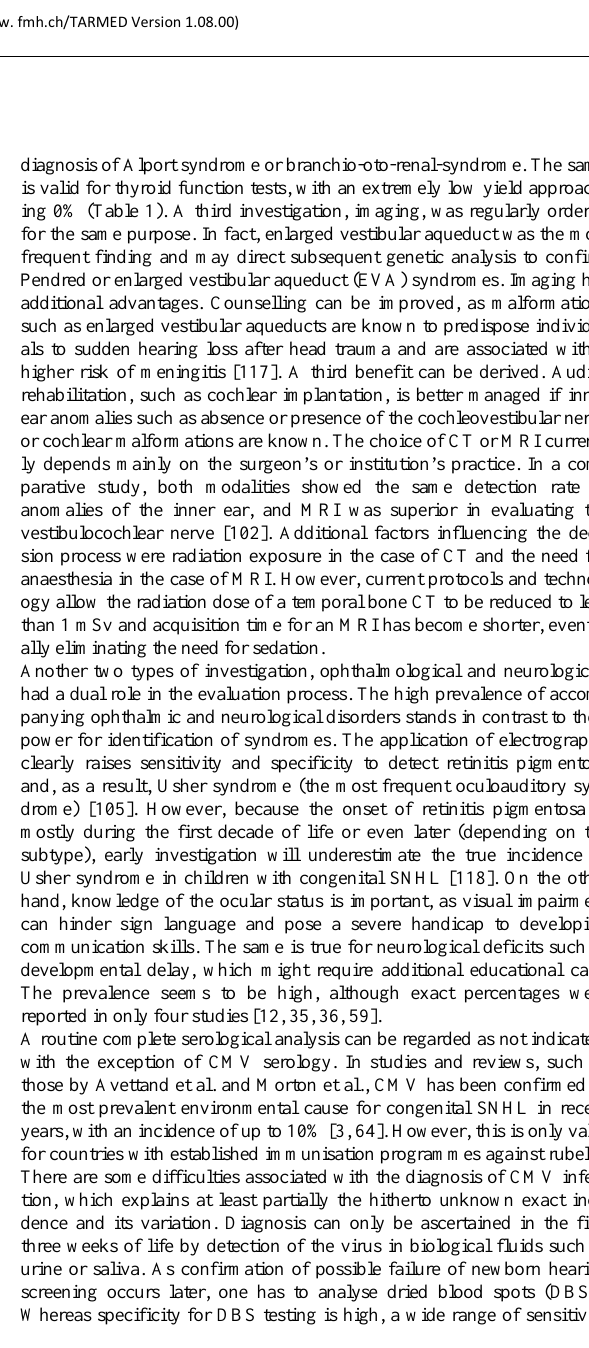
Exchange rates: 1.1 EUR/CHR; 1